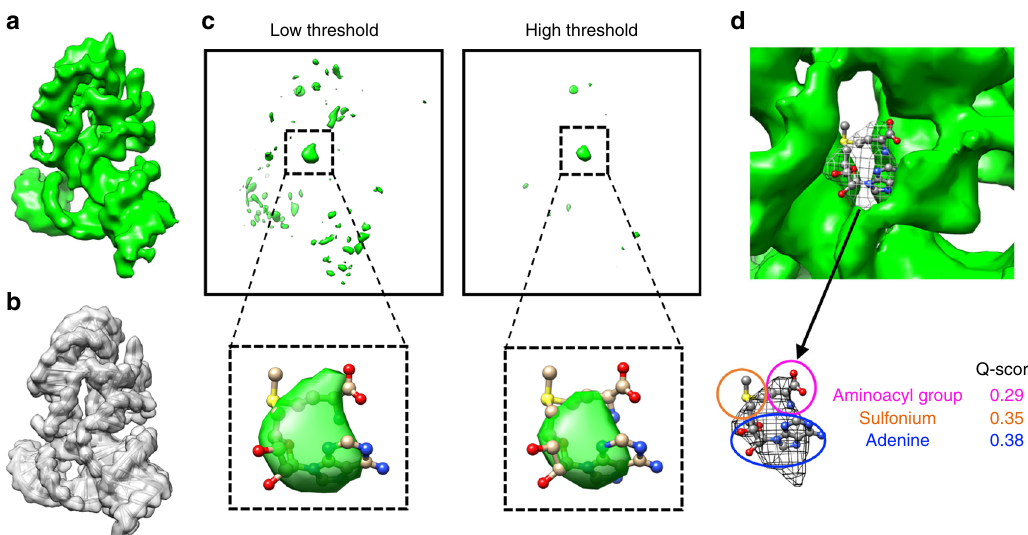
Fig. 3 Determination of the ligand location in the ligand-bound SAM-IV cryo-EM map. a Ligand-bound SAM-IV cryo-EM map. b Map computed from the SAM-IV RNA-only model from a . c Difference map between a and b shown at two different thresholds. The insets show the prominent density in the difference map into which are fi tted the ligand model derived from SAM-I crystal structure (PDB code: 3GX5). d Segmented SAM density from a is highlighted in a wire frame representation, fi tted with the ligand model derived from SAM-I crystal structure (PDB code: 3GX5). Q-scores of the ligand components between the map and model are